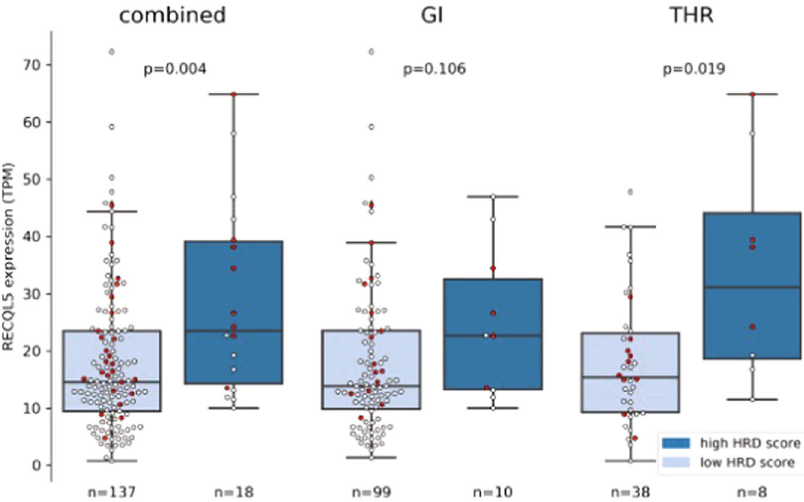
Fig. 3 Box plot showing RECQL5 expression in patients with low and high HRD scores in combined and individual GI and thoracic (THR) cohorts. The data points are colored in red if the RECQL5 gene is subjected to copy gain or ampli fi cation. All p values presented on the boxplots are determined by Wilcoxon rank sum test (Holm-Bonferroni correction). Box plots represent the median (black line), upper (75th) and lower (25th) quartiles of the distribution and whiskers represent the limits of the distribution (1.5-times interquartile